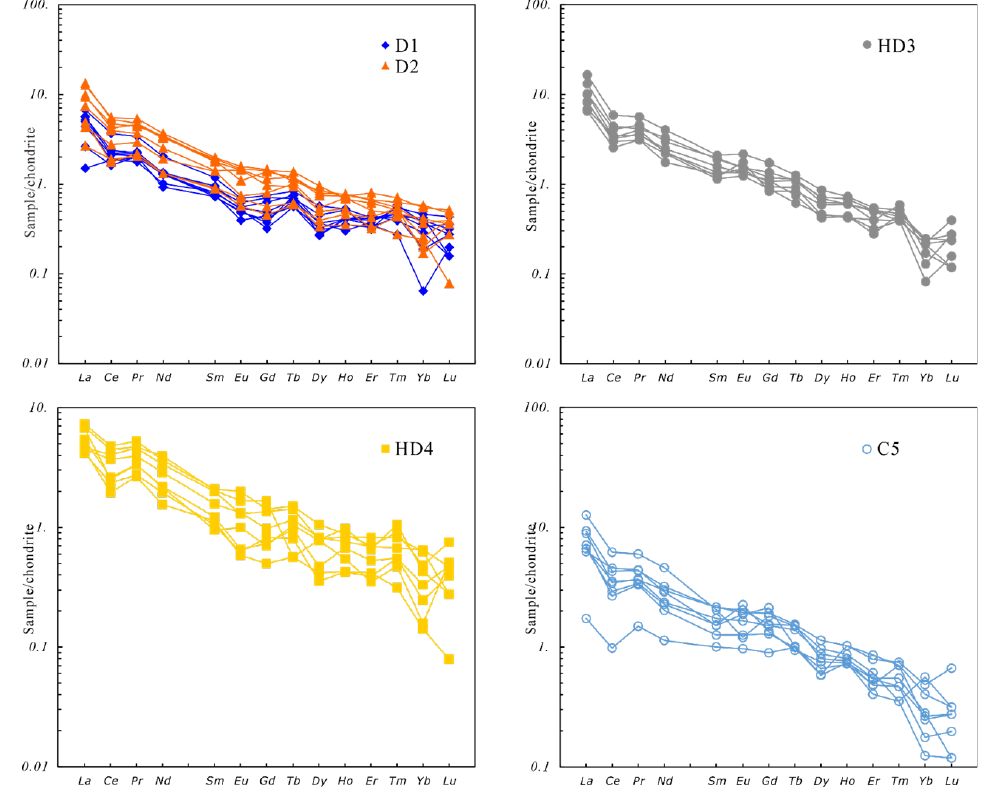
Figure 10. Chondrite-normalized REE patterns of dolomites from the Fuli Pb-Zn deposit (normaliza- tion values after Sun & McDonough